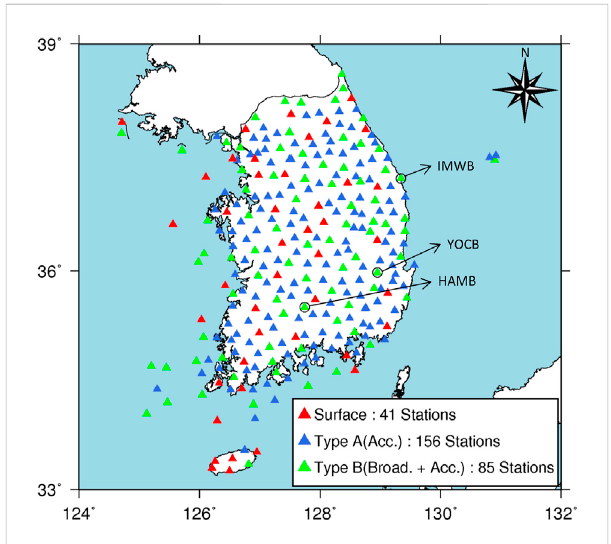
National seismic monitoring network on Korean Peninsula installedbyKMA.ThetriangularmarksindicatetheSurface(red),Type- A (blue: accelerometer at 20 m depth), and Type-B (green: accelerometerat20 mandbroadbandat100